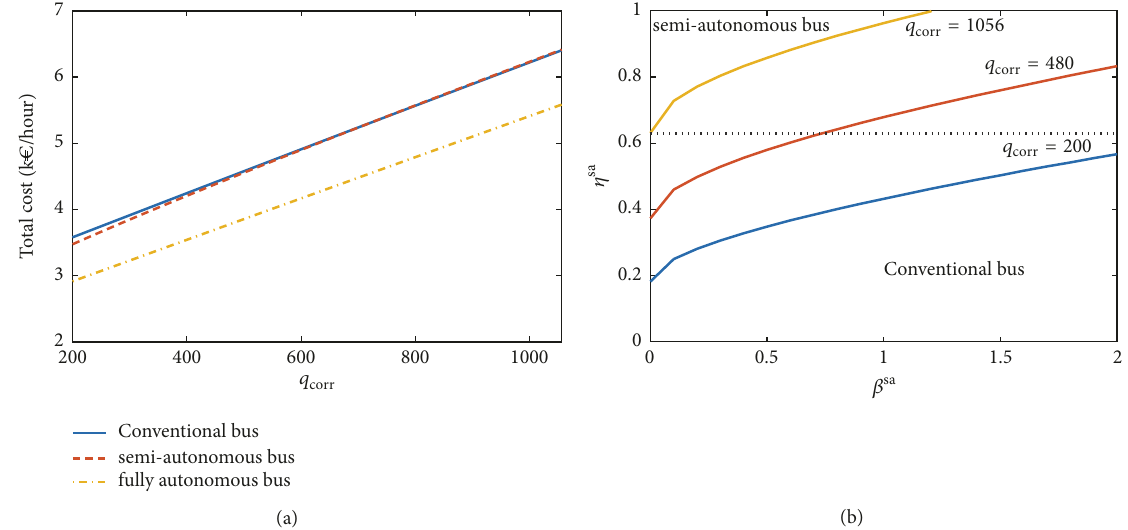
Figure 5: (a) Total cost and (b) applicability of semi-autonomous buses with respect to different levels of demand on the corridor. Note that the top-left side of each curve in (b) indicates the preferable region of semi-autonomous buses, whereas the other side is for conventional buses. The dotted line gives the upper bound of 𝜂 sa , which is 0.63. Other parameters according to Table